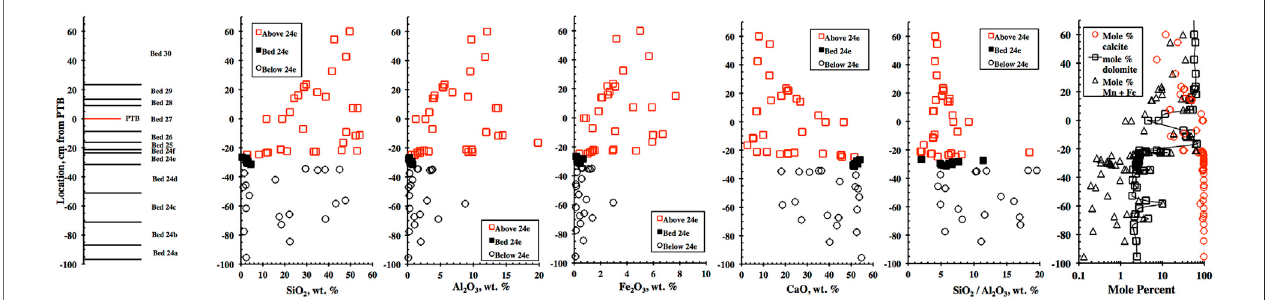
FIGURE 2 | Major element whole rock data, plotted stratigraphically. Two values of Fe 2 O 3 in bed 24f ( − 21 cm) are off scale. Calculated proportions of calcite, dolomite, and rhodochrosite are plotted on a log scale. See text for limitations on the estimates of these mineralogical abundances.